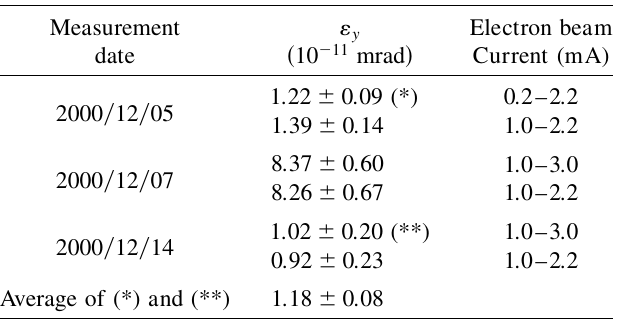
TABLE IV. Summary of the vertical emittance measure-